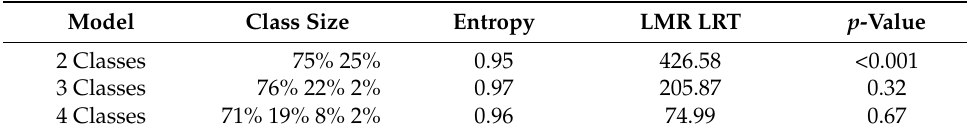
Table 3. Latent class models